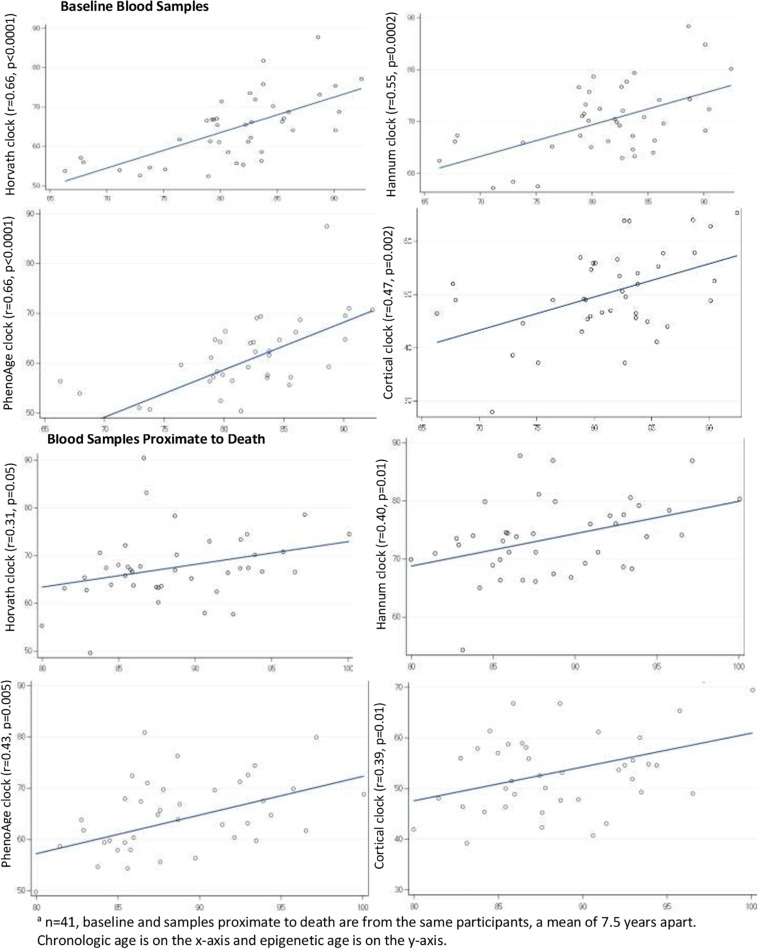
Pearson correlations of epigenetic age to chronologic age in blood samplesa.